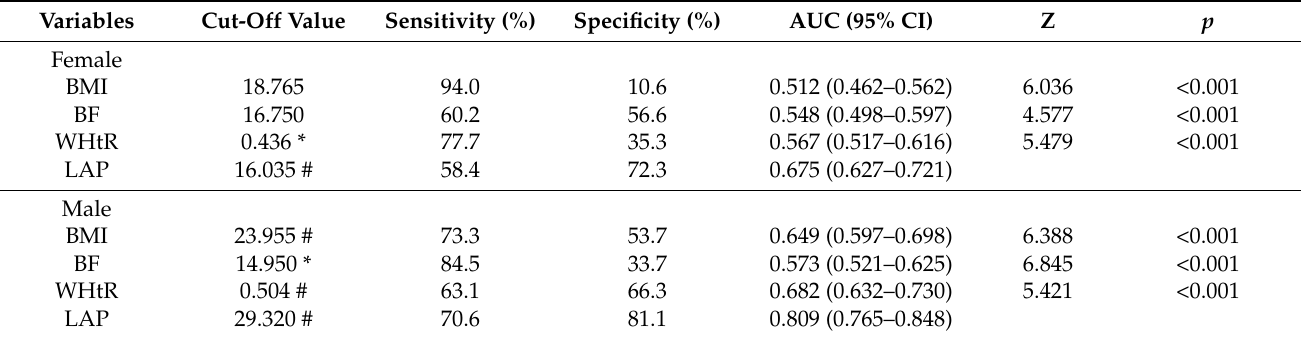
Table 4. The comparisons of Health-Related Physical Fitness Indicators in predicting dyslipi- demia